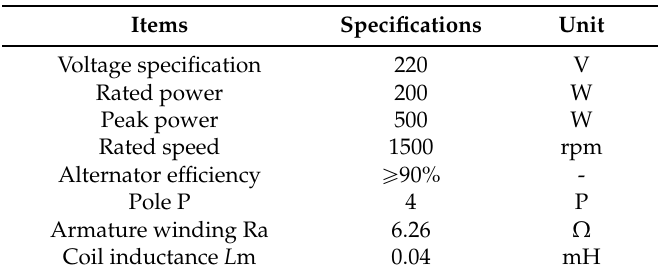
Table 1. GBEE specifications.